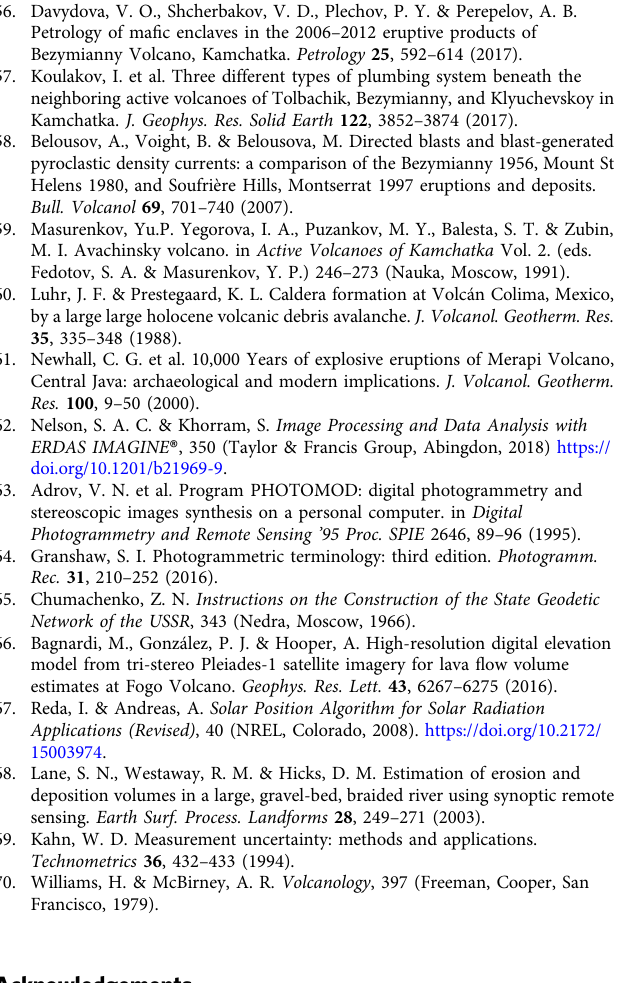
Figs. 1 – 6 and 8. R.M. processed the 2017 UAV-Pleiades data set. T.R.W. supervised the project, contributed to the data processing and analysis, and together with R.M.,